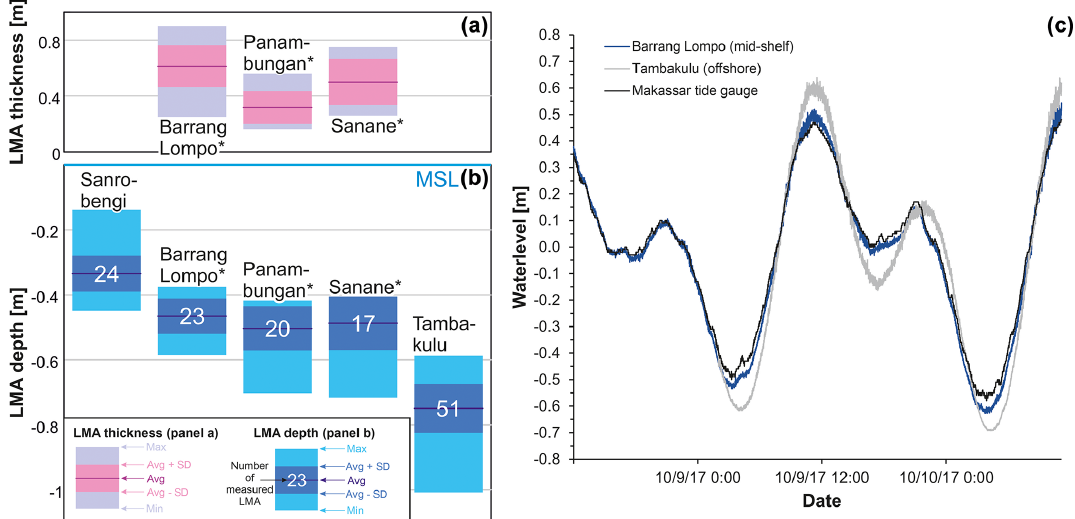
Figure 4. (a) Thickness of living microatolls (LMAs) measured by Mann et al. (2016) in the Spermonde Archipelago. The average of the three islands reported is 0 . 48 ± 0 . 19m. (b) Measured depth of LMA in this study (Sanrobengi and Tambakulu islands) and in Mann et al. (2016). The asterisk in (a, b) indicates the islands surveyed by Mann et al. (2016). In (a, b) the islands are ordered from that closest to the shore on the left side to those further away from the shore on the right side. (c) Comparison between water levels measured at Barrang Lompo (located on the mid-shelf), Tambakulu (located offshore towards the edge of the shelf) and data recorded by the national tide gauge at Makassar harbor. Note that, in (a, b) , “zero” refers to mean sea level, while in (b) “zero” refers to the average water level over the measurement period (here 8–10 October